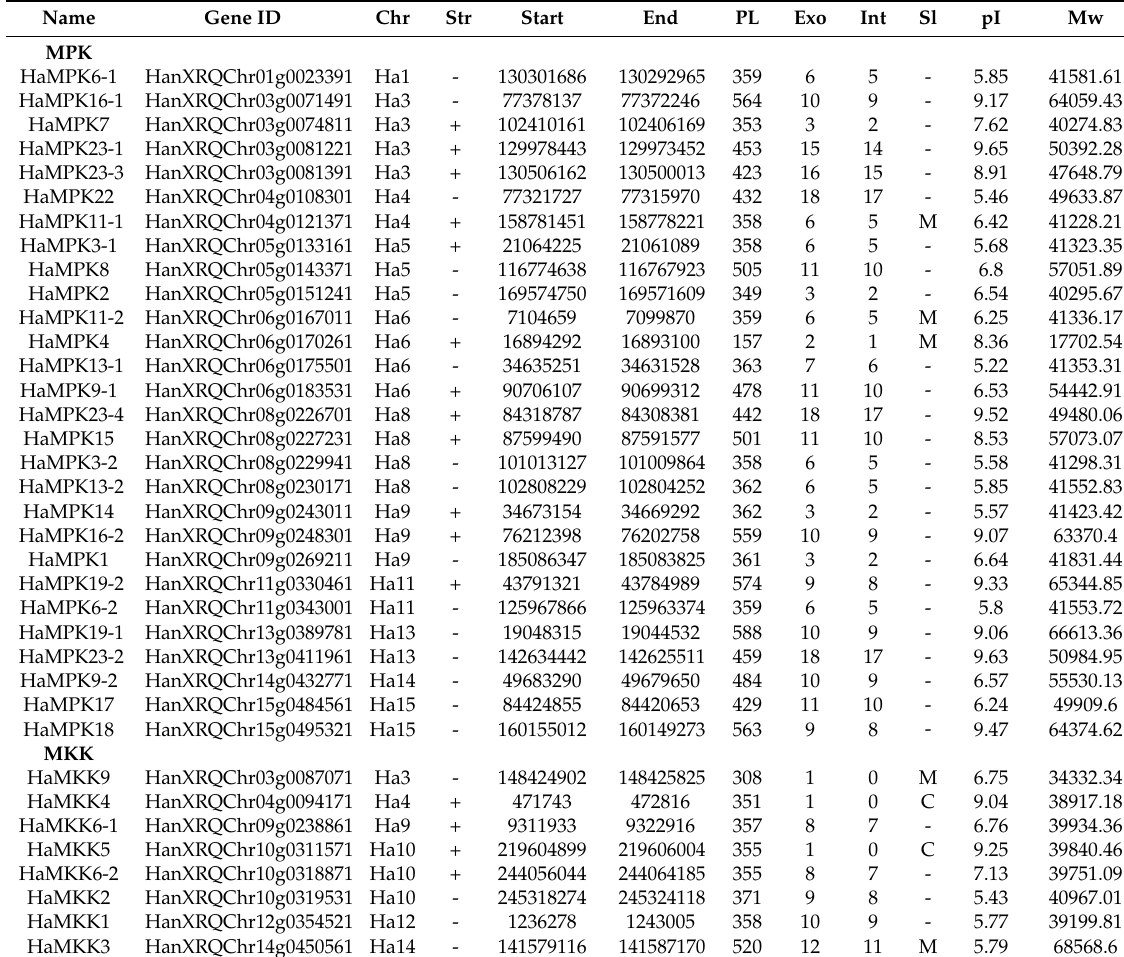
Table 2. Sunflower MPK and MKK genes with their proposed name, GeneID, chromosomal location (Chr), strand direction (Str), start and end position of the genes on chromosome, protein length (PL), number of exon (Exo) and intron (Int), subcellular localization [Sl; M = Mitochondria and C = Chloroplast, - = Subcellular locations other than mitochondria or the chloroplast), isoelectric points (pI) and molecular weight